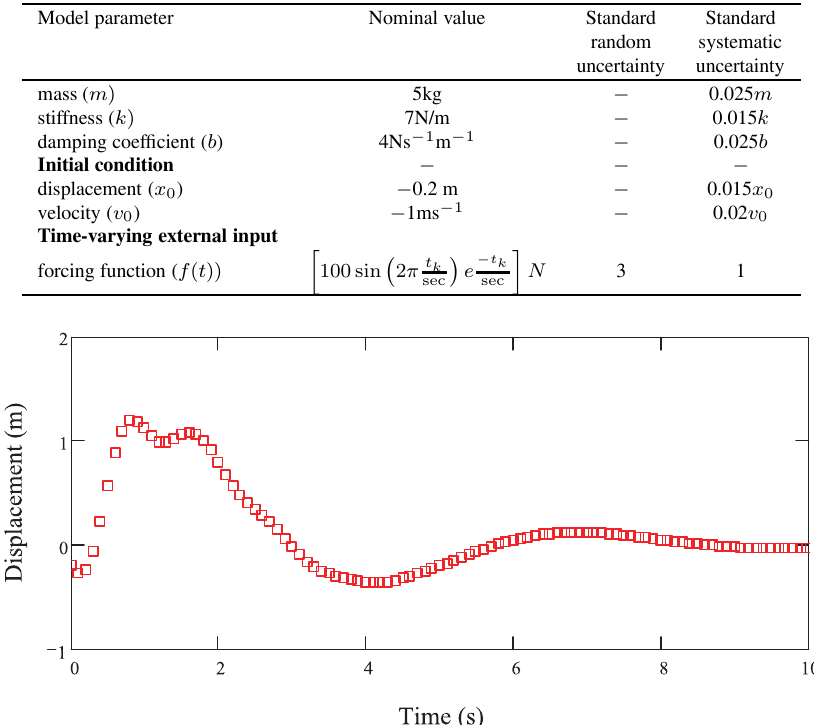
Fig. 2. SDOF system time-varying displacement resultss.